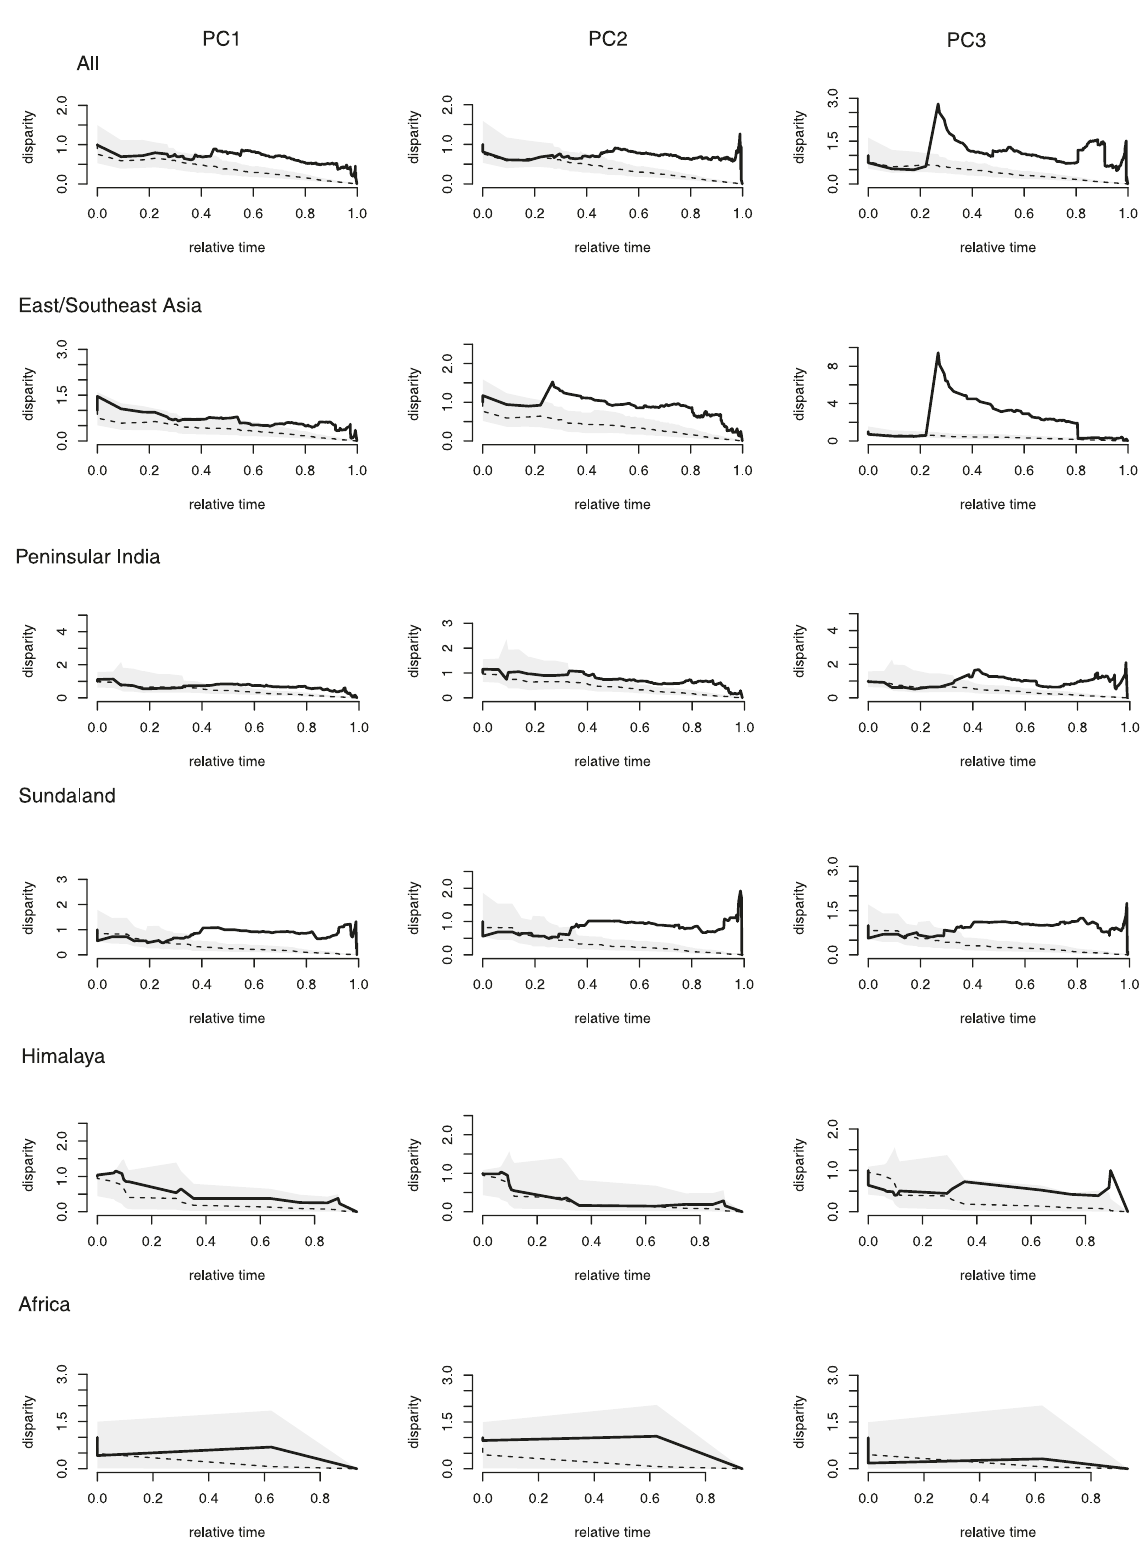
Fig. 4 Relative disparity-through-time (DTT) plots of PC scores representing rhacophorid climate niches. Solid lines indicate observed DTT values; dashed lines and the corresponding polygons represent averages and 95% con fi dence intervals, respectively, of the expectations given a constant accumulation of disparity over time based on 999 pseudoreplicates. The disparity of climate niche evolution is higher in all biogeographic regions except Africa, especially during the second half of the diversi fi cation. Markedly higher levels of disparity are observed in PC3 (higher summer temperature) early in the evolution of species from East/Southeast Asia and peninsular India, and recently in species from Sundaland.